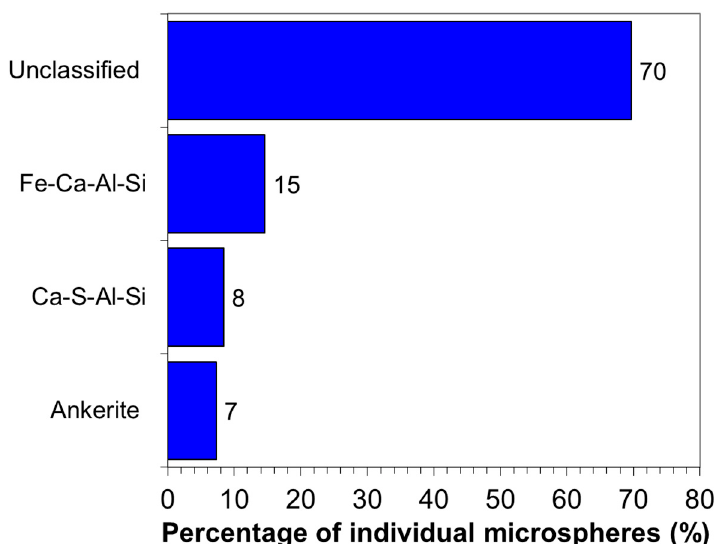
Figure 5. Mineral species for microspheres in the narrow fraction (analysis of 178 globules with d = 1–2 µm) according to the elemental composition criteria from Refs. [50,51]. d = 1–2 µ m) according to the elemental composition criteria from Refs.